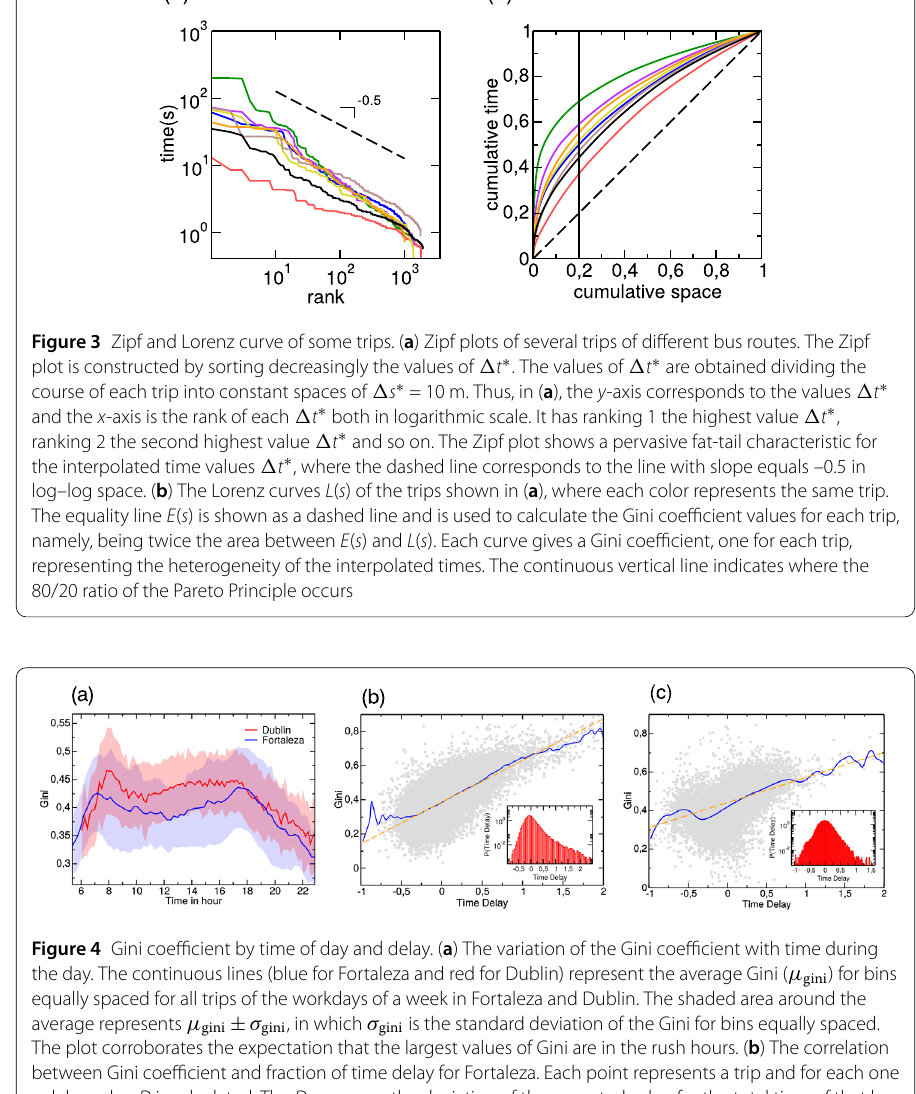
dard deviation ( σ gini ) of Ginis were computed for bins of same sizes. The dashed areas around the average represent μ gini ± σ gini . As depicted, the two peaks present in Fig.